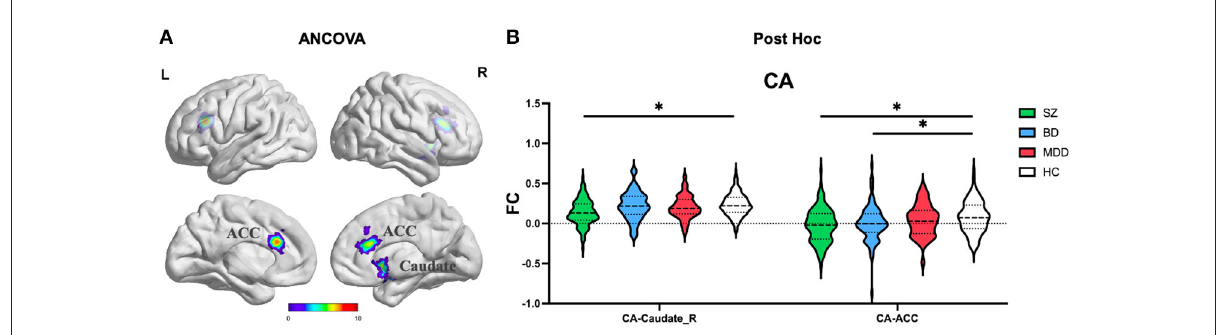
FIGURE2 The FC alterations of CA subregion analyzed by (A) ANCOVA analyzed. (B) The post hoc pair-wise t test. FC, Functional Connectivity; CA, Cornu Ammonis; ANCOVA, Analysis of Covariance; SZ, Schizophrenia; BD, Bipolar Disorder; MDD, Major Depressive Disorder; GRF, Gaussian Random Field. ANCOVA: Significance was set at cluster p < 0.05 corrected using GRF with voxel p < 0.005. Post-hoc : *Significance was set at cluster p < 0.05 corrected using GRF with voxel p <